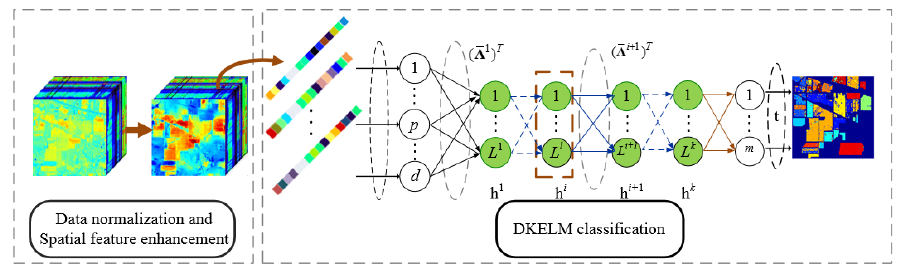
Figure 3. The main procedure of our proposed framework. ¯ Λ ( 1 ) is the first layer’s transformation matrix of DKELM got from the KELM-AE of the input data. ¯ Λ ( i + 1 ) refers to the transformation matrix of ( i + 1 ) - th hidden layer h i + 1 of DKELM, which obtained by KELM-AE of the i -th hidden layer h i